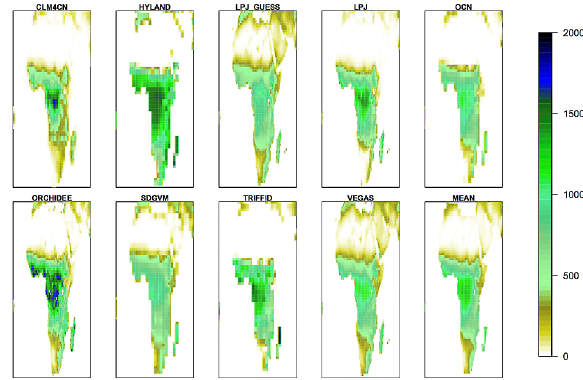
Table 6. DGVM average carbon pools (PgC) and fluxes (PgCyr − 1 ) over the period 1990–2009, NBP is defined as